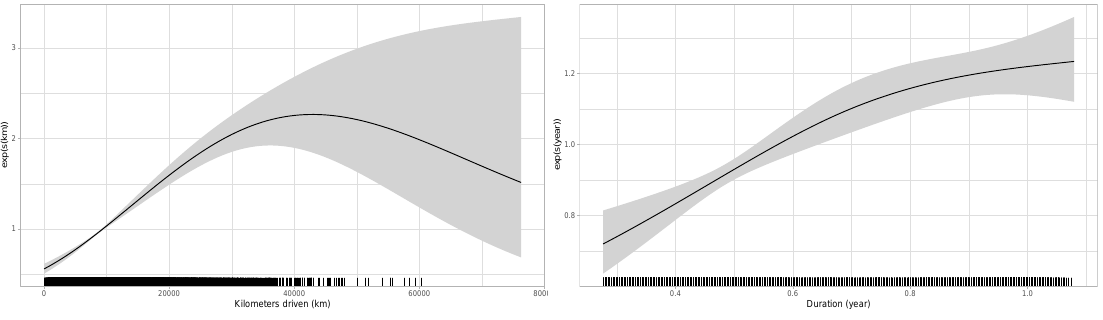
Figure 9. exp ( ˆ s 1 ( km )) and exp ( ˆ s 2 ( year )) from the Poisson GAM estimated with Canadian